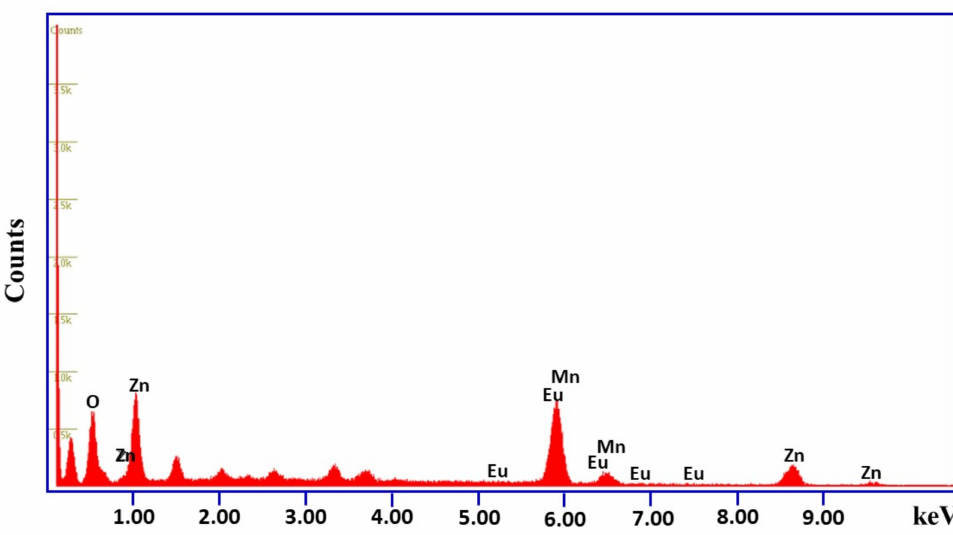
Figure 5. EDX spectrum of the synthesized Mn 3 O 4 /ZnO/Eu 2 O 3